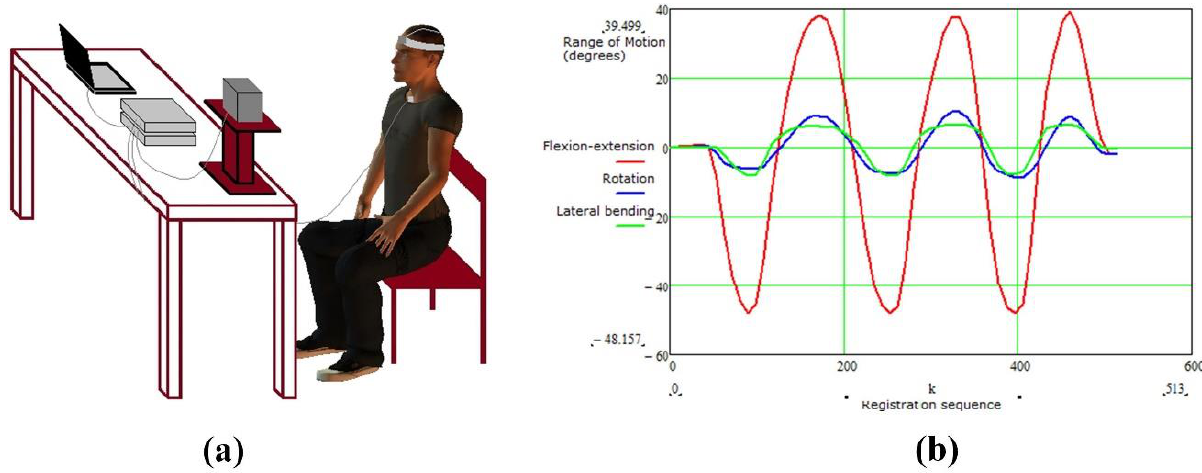
Figure 13. Three-dimensional electromagnetic tracking system. ( a ) Schematic diagram of detection device. ( b ) Movement measurement signal. Adapted with permission from ref. [107]. Copyright 2018 Elsevier.